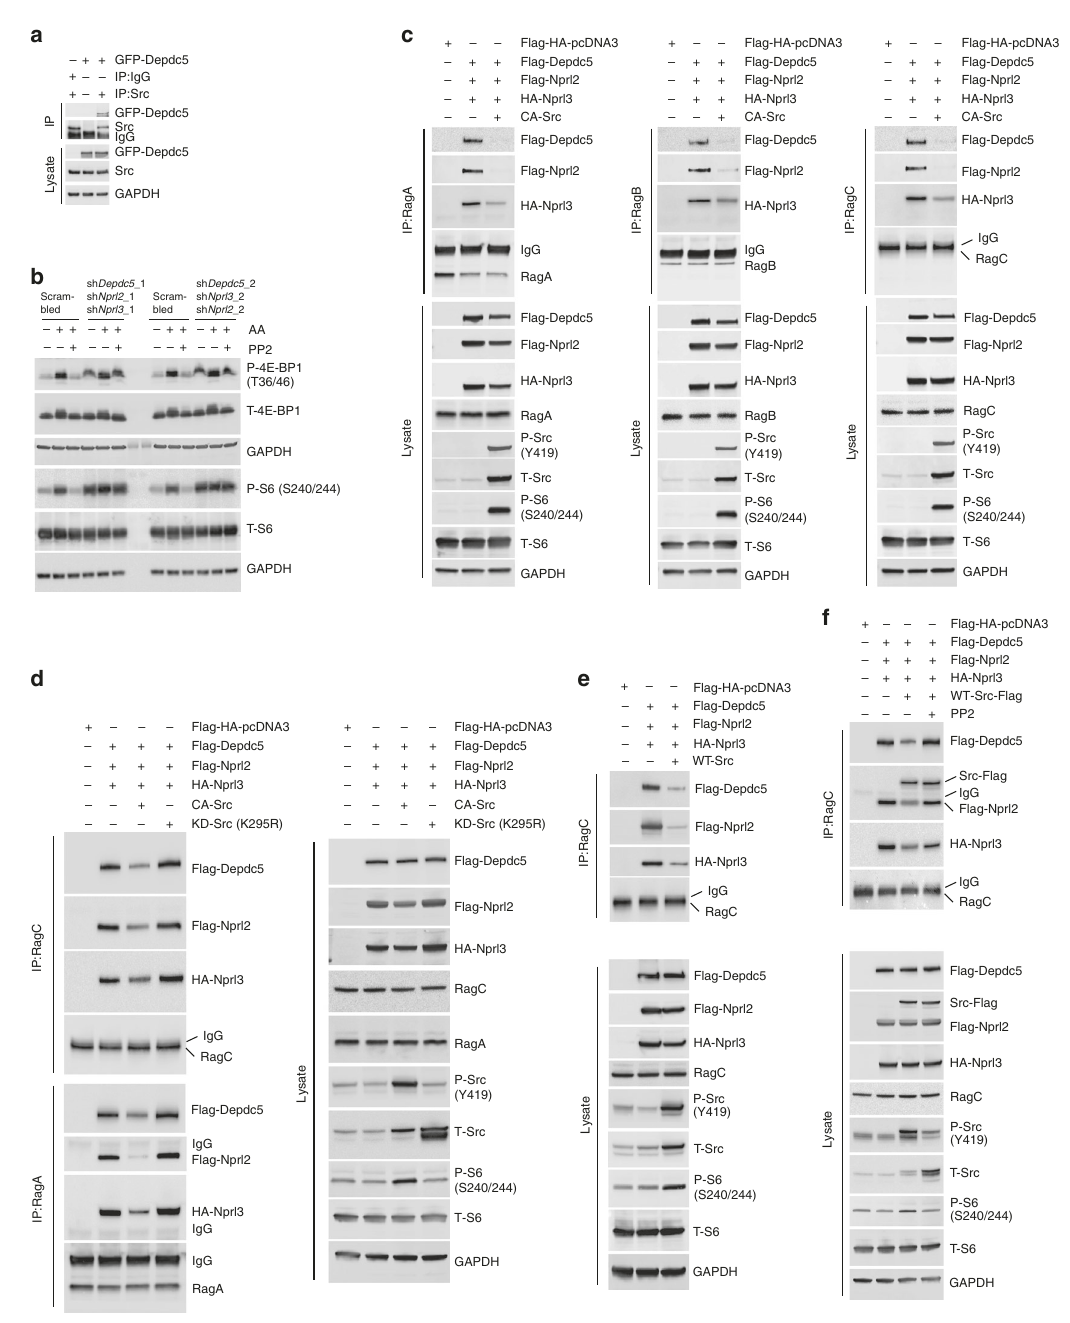
Fig. 4 Src kinase disrupts the interaction of GATOR1 with the Rags. a Src kinase interacts with the GATOR1 complex. HEK293 cells, transiently transfected with GFP-Depdc5, were lysed and subjected to immunoprecipation with antibodies against Src or IgG (negative control) followed by immunoblotting for the indicated proteins. Lysates were probed with antibodies as indicated. b HEK cells, transiently transfected with scramble shRNA or shRNAs targeting DEPDC5 , NPRL2 , and NPRL3 genes for 48 h prior to starvation and treatment with vehicle (DMSO) or PP2 for the last 2 h of starvation and then stimulated with amino acids (30 min). Immunoblot analyses were performed to measure the levels of the indicated proteins and phosphorylation states. c HEK293 cells, transiently transfected with the components of GATOR1 and constitutively active Src (CA-Src), were lysed and coIP analyses were performed to test interaction of GATOR1 with RagA, RagB, or RagC. d HEK293 cells, transiently transfected with GATOR1 components, CA-Src or kinase-dead Src (K295R), were lysed and coIP analyses were performed to test interaction of GATOR1 with RagA or RagC. e HEK293 cells, transiently transfected with the components of GATOR1 and wild-type Src (WT-Src), were lysed and subjected to RagC immunoprecipitation (IP) followed by immunoblotting for the indicated proteins. Lysates were probed with antibodies as indicated. f Inhibition of Src kinase promotes GATOR1 – Rag interaction. HEK293 cells transfected as in e were treated with PP2 (5 μ M, 24 h) prior to lysis, and then subjected to RagC immunoprecipitation (IP) followed by immunoblotting for the indicated proteins. GAPDH was used as a loading control in all immunoblot